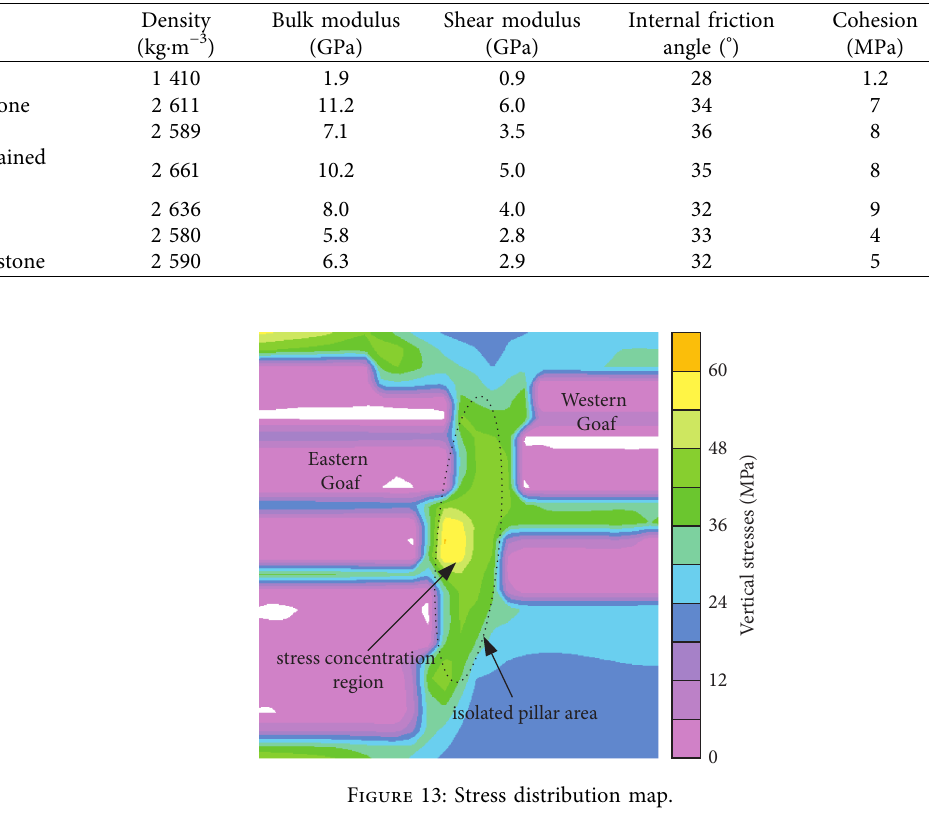
Figure 12: Central mining district model diagram. Table 3: Main coal and rock mechanics parameters.